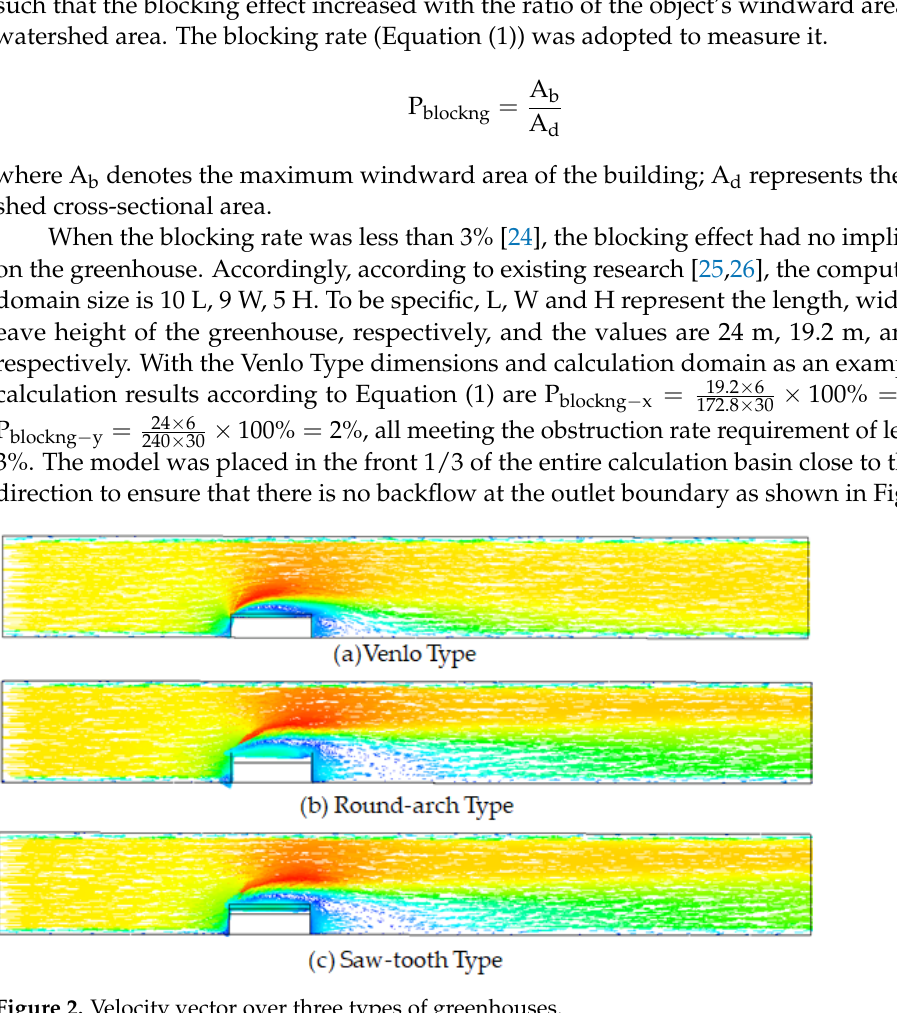
Table 3. Grid quality evaluation criteria.